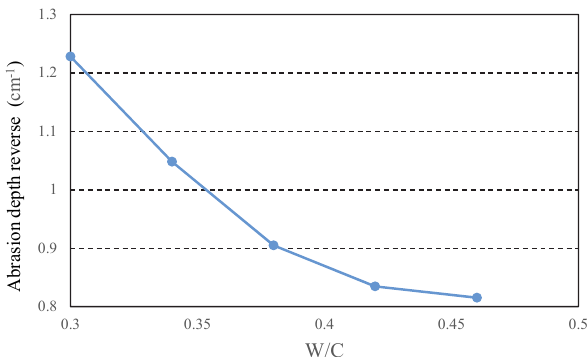
Figure 3: Abrasion depth reverse in terms of water-cement ratio